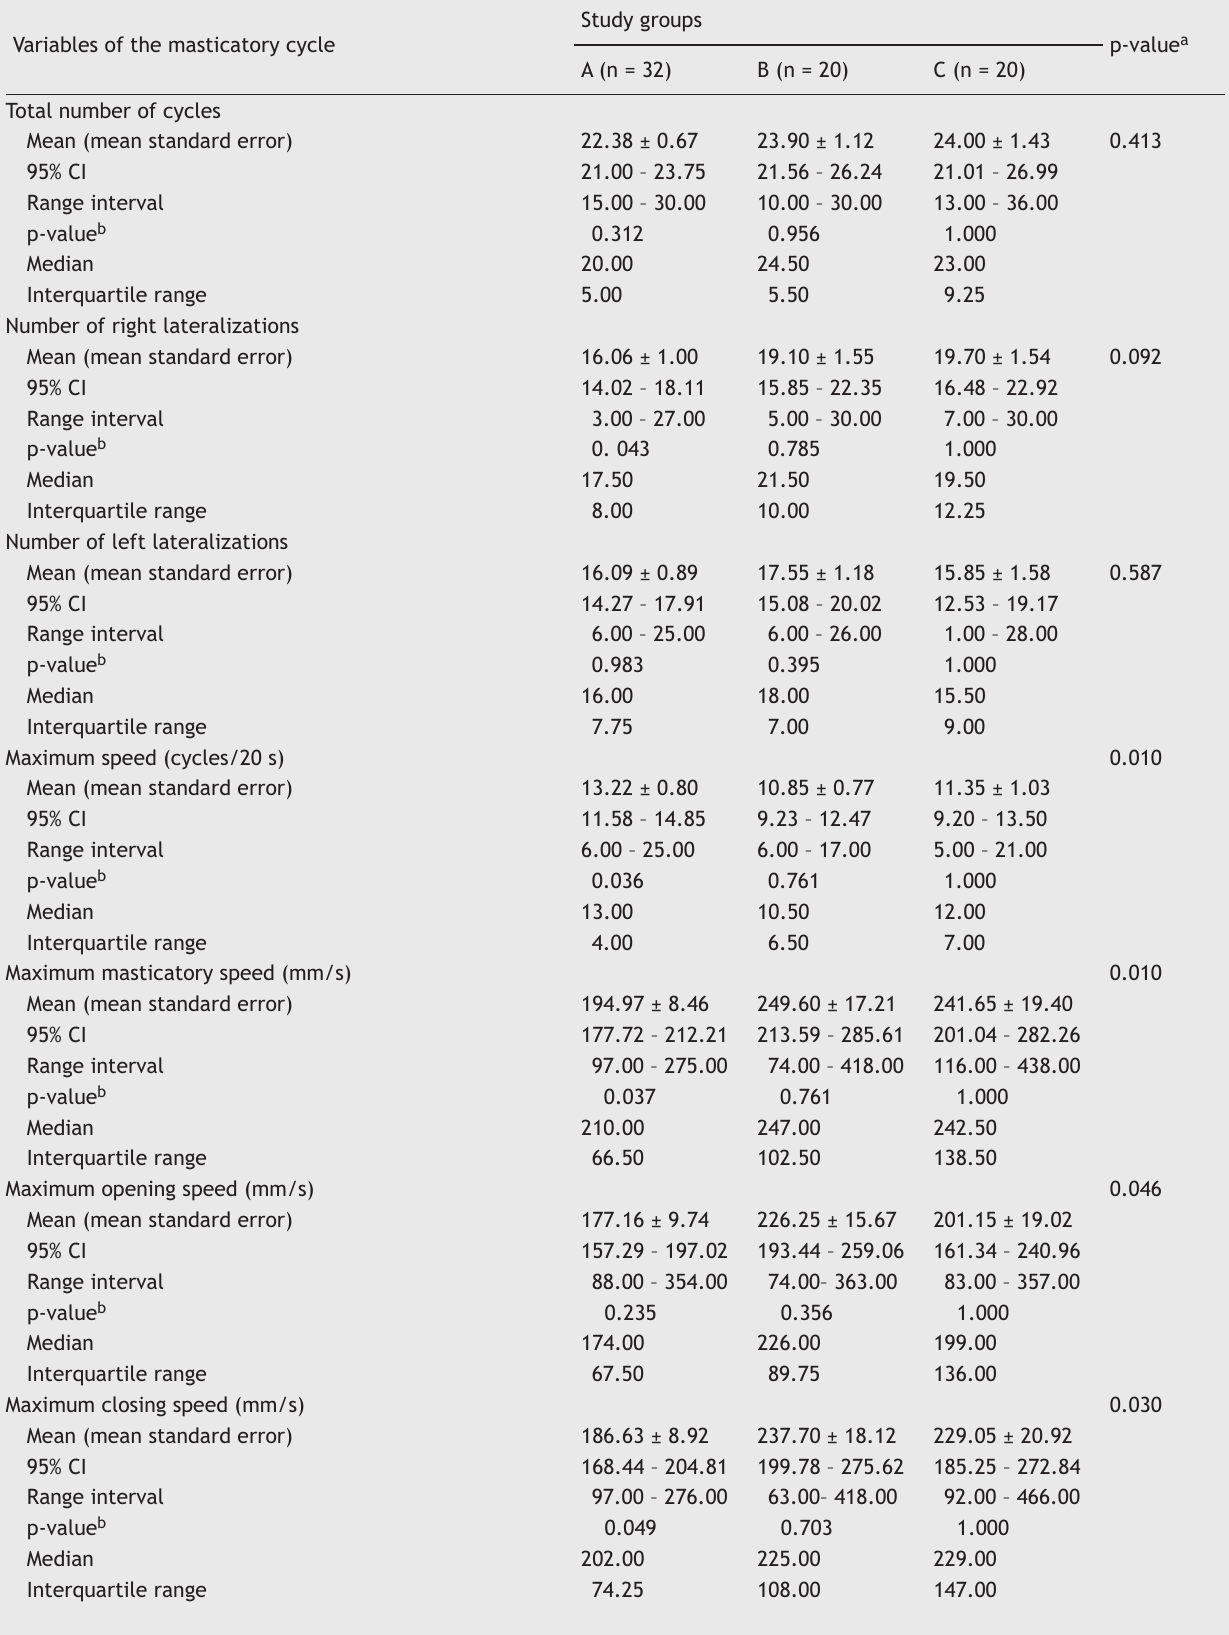
Table 1 Statistical parameters of the masticatory